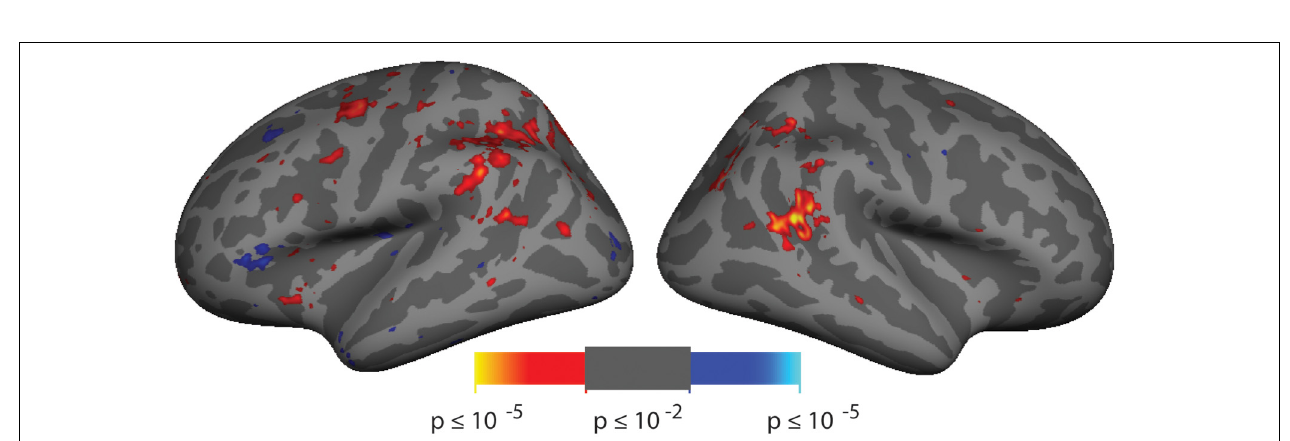
FIGURE 2 | Spatial cueing group-averaged activation. A group-average analysis ( N = 10) of invalidly (hot colors) vs. validly (cool colors) cued targets ( p < 0.01, uncorrected). Activation is observed in right hemisphere around the posterior end of the superior temporal sulcus (STS) near the border with the parietal lobe.